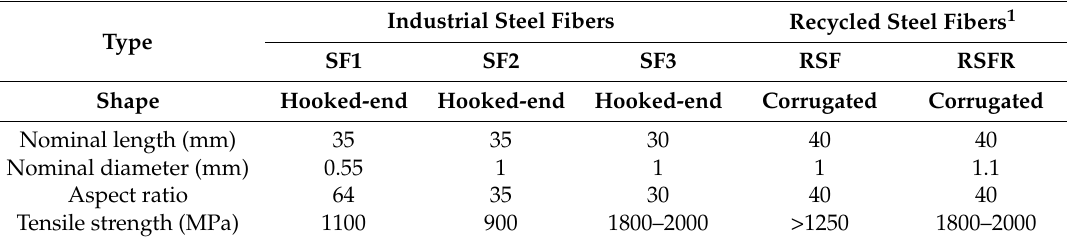
Figure 1. Steel fibers in this investigation: ( a ) Steel fiber (SF)1; ( b ) SF2; ( c ) SF3; ( d ) recycled steel fiber (RSF); ( e ) recycled steel fiber with rubber (RSFR). (RSF); ( e ) recycled steel fiber with rubber (RSFR). Table 1. Characteristics of steel Table 1. Characteristics of steel fibers.